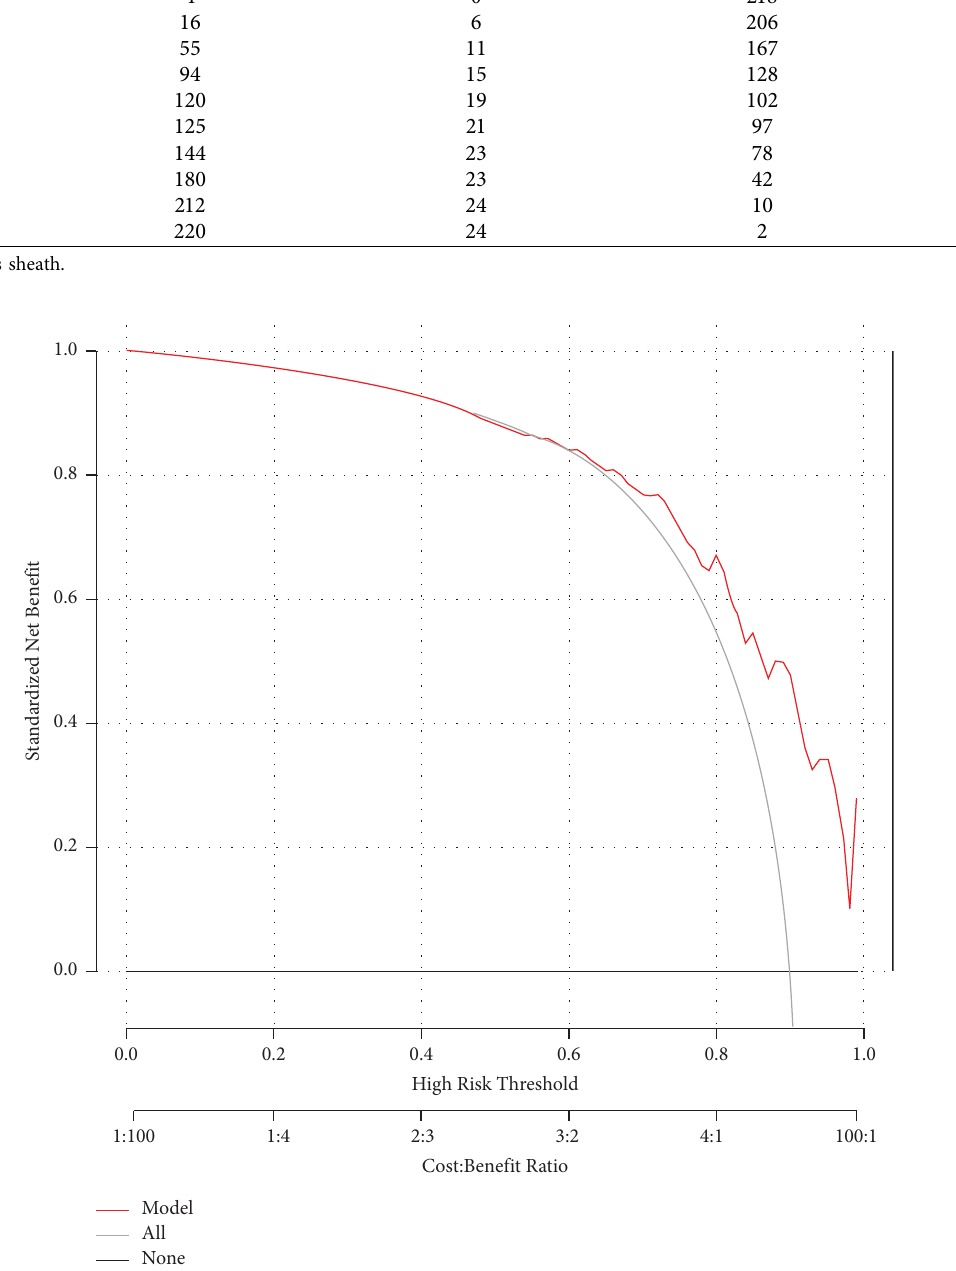
Figure 4: Decision curve analysis of the logistic